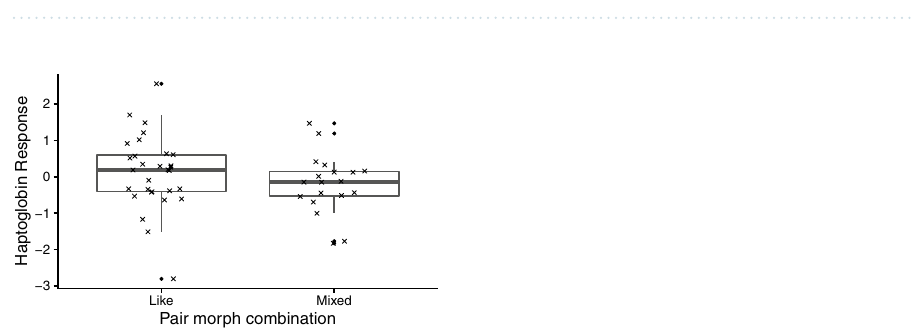
Figure 1. Baseline innate immune parameters (scaled values and centred to the mean of the year) in relation to pair morph combination (‘like-morph’: dark-dark D ♂ D ♀ and light-light L ♂ L ♀ ; or ‘mixed-morph’: dark–light D ♂ L ♀ and light–dark L ♂ D ♀ ). Boxplots are based on standardized raw data (individual data values shown as cross marks), outliers shown as black points, grey outlined violin plot gives an estimate of the distribution of data. Differences were not significant.